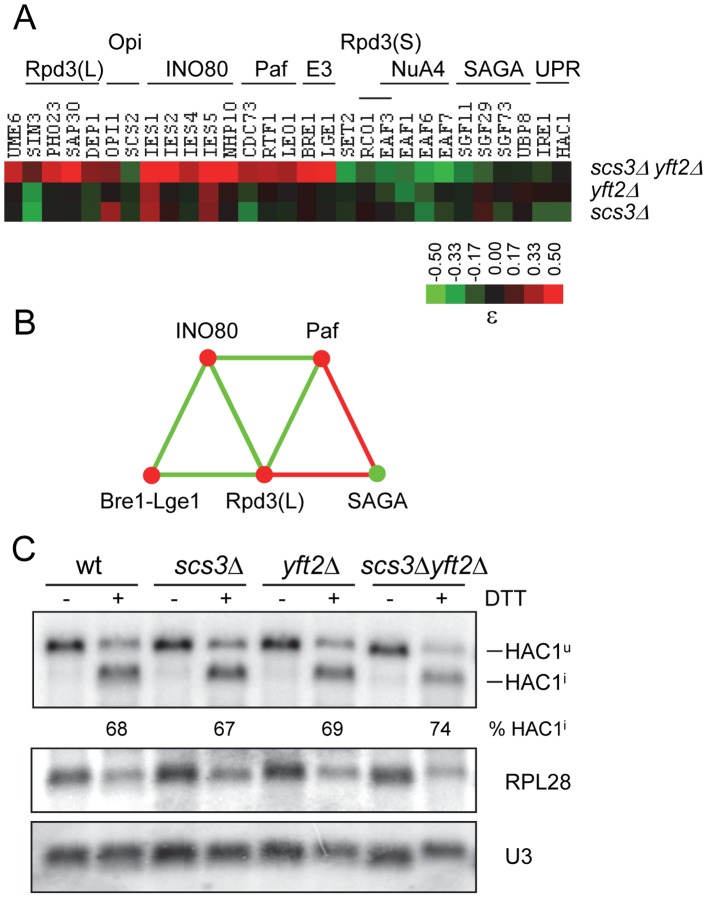
Functional relationships between SCS3 and YFT2 and transcriptional components associated with the expression of phospholipid biosynthetic genes.(A) The heat map shows array genes that interact genetically with deletions of SCS3, YFT2 or both genes. The strength of the interactions is indicated by the colorbar. Array genes are grouped according to the transcription complexes or activities/pathways that define their function as indicated above the heat map. Supporting interactions that are not represented in the high stringency set were identified using relaxed criteria and include UME6 and LGE1 (p = 0.02), DEP1, which had a 39 pixel size difference just below the 40 pixel cutoff and UBP8 (ε = −0.09 in the triple mutant). Genetic interactions with EAF1 were identified with OPI7 which encodes a dubious ORF that overlaps the N-terminus and promoter of EAF1. (B) Genetic relationships between transcription components that interact with SCS3 and YFT2 (panel A) were determined by searching the DryGin database [78]. This resulted in the identification of three linked triplet genetic motifs. Each edge connecting the complexes in this network represents a minimum of three interactions, either all alleviating (red) or all aggravating (green). The same color scheme is used for nodes which indicate the type of interaction of the different complexes with the SCS3 YFT2 double deletion strain (as in panel A). (C) Analysis of the unfolded protein response (UPR) pathway in SCS3 and YFT2 gene-deletion strains. Northern analysis of HAC1 mRNA (reporting both unspliced Hac1u and spliced Hac1i forms), stable U3 snRNA and RPL28 mRNA was performed on RNA from early log phase cultures (SC-medium) of wild-type and double deletion strains before and after DTT treatment. The Hac1 band intensities were used to calculate the distribution between spliced and unspliced forms. Normalized HAC1 mRNA band intensities were used to determine the level of transcription relative to the wild-type untreated strain. The RPL28 mRNA levels are included to report the global cellular stress response to DTT treatment. Results from duplicate independent samples of wild-type and double deletion strains are reported under the representative autoradiogram.